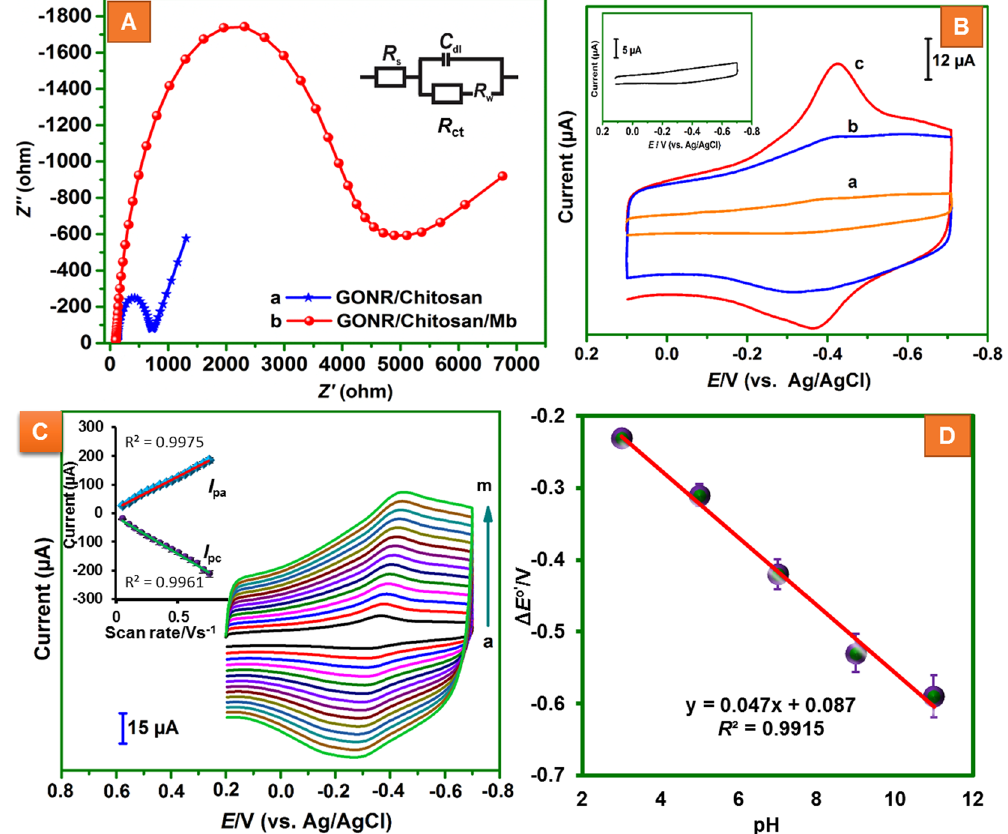
Figure 3. ( A ) EIS curves of GCE/MWCNTs@rGONRs/CHIT (a) and GCE/MWCNTs@rGONRs/CHIT/Mb (b) obtaiend in 0.1 M KCl containing 5 mM Fe(CN) 63 − /4 − . Amplitude: 5 mV, Frequency: 0.1 Hz to 100 kHz. Inset: Randles equivalent circuit; R s , R ct , C dl , and W are electrolyte resistance, charge transfer resistance, double layer capacitance and Warburg impedance, respectively. ( B ) CVs obtained at GCE/Mb (inset), GCE/CHIT/Mb (a), MWCNTs@rGONRs/Mb (b), and MWCNTs@rGONRs/CHIT/Mb (c) films modified GCEs in phosphate buffer (pH 7). Scan rate = 50 mVs − 1 . ( C ) Effect of scan rate: CV obtained at GCE/MWCNTs@rGONRs/CHIT/Mb in phosphate buffer (pH 7.0) at different scan rates (a = 0.05, b = 0.10, c = 0.15, d = 0.20, e = 0.25, f = 0.30, g = 0.35, h = 0.45, i = 0.50, j = 0.55, k = 0.60, l = 0.65, m = 0.70 and n = 0.75 V s − 1 ); Inset: Plot of peak currents ( µ A) vs. scan rate (Vs − 1 ). ( D ) Plot between formal potential ( Δ E 0 ’) vs. pH; CVs were carried out at different